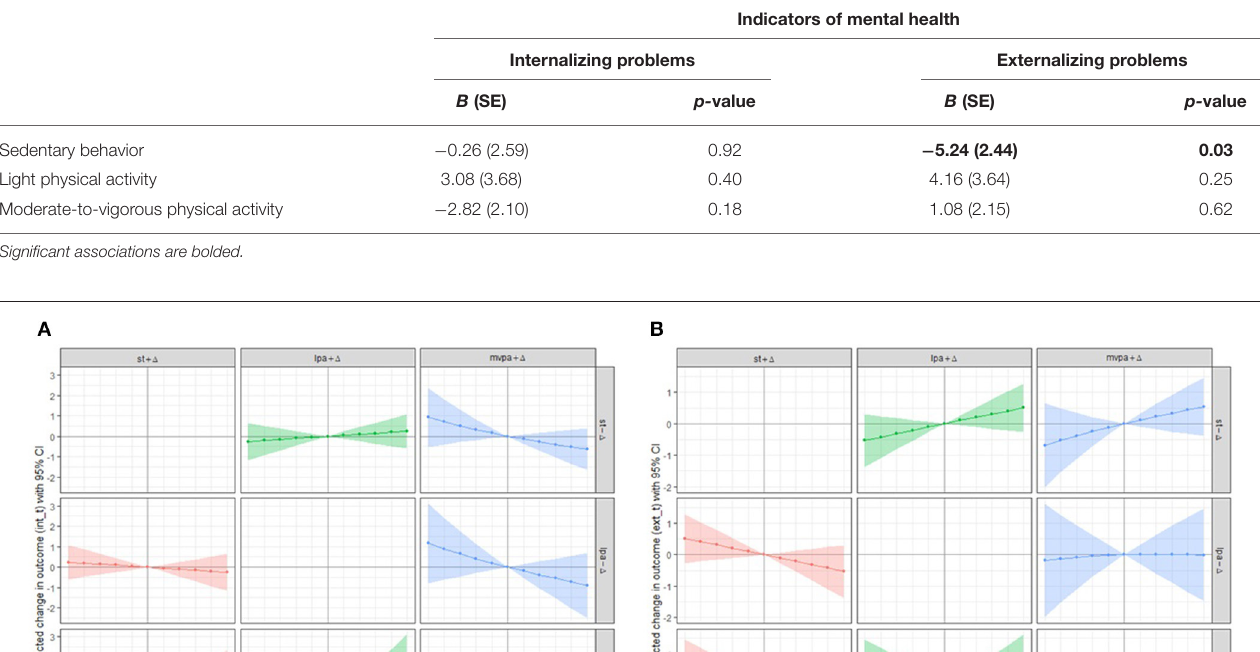
TABLE 2 | Associations between movement compositions and indicators of mental health.